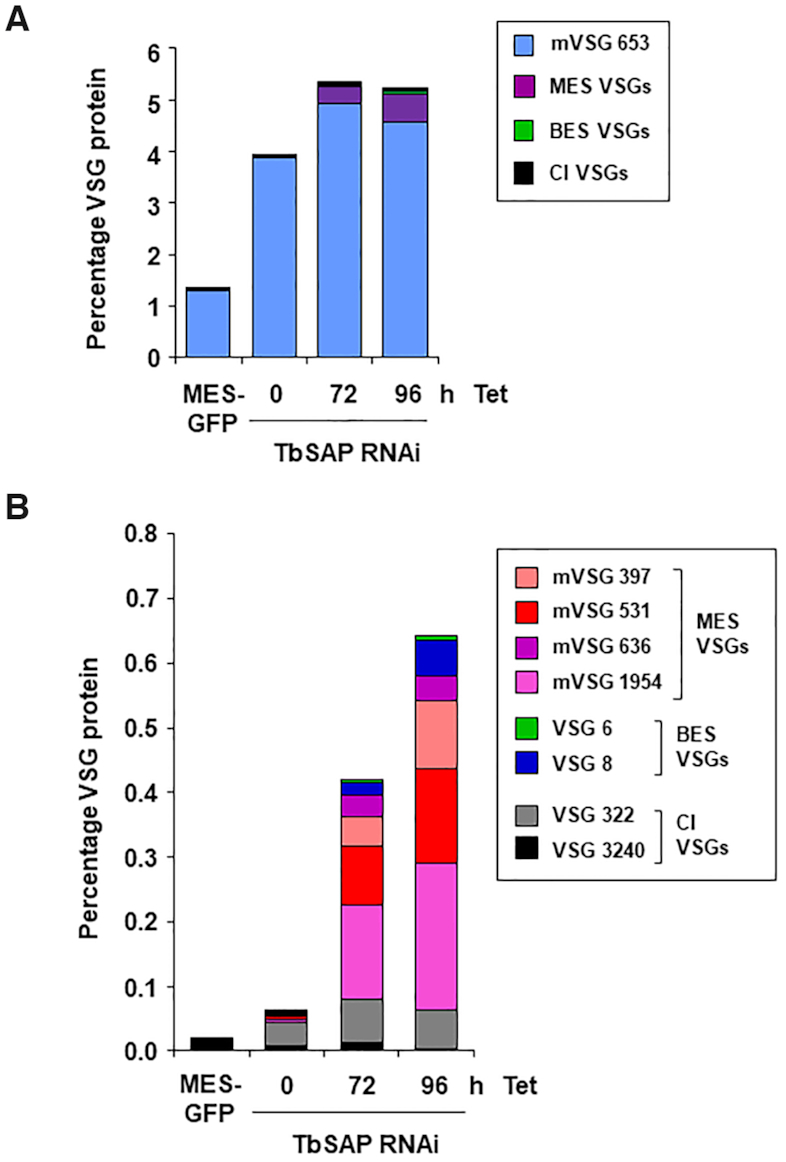
Multiple up-regulated VSGs are present on the cell surface following the induction of TbSAP RNAi (A) Quantitative proteomic analysis using mass spectrometry of surface VSGs cleaved by release of endogenous GPI-PLC after hypotonic lysis. Samples are from the parental VSG221 expressing SM221pur MES-GFP cells (MES-GFP) or cells where TbSAP RNAi has been induced with tetracycline (Tet) for the time indicated in hours (h). VSG221 expressed from the active BES1 is omitted from the BES VSGs dataset, as it displayed an abundance of 95–99% in each sample. In these cell lines MES VSG653 is expressed from readthrough transcription from an ectopic rDNA promoter introduced upstream of the VSG653 gene. The different classes of VSGs are indicated with coloured bars, with MES VSG653 indicated with a blue bar, other MES VSGs (purple), BES VSGs (green bar) or VSGs in chromosome internal (CI) silent VSG arrays (black). Data are the mean of three biological replicates. (B) As in panel (A) only both MES VSG653 and VSG221 are omitted from the VSG dataset, as together they made up >99% of the sample. Different types of VSGs (present in either MESs or BESs) are indicated with coloured bars, with VSGs not located in ESs indicated as CI VSGs (grey and black bars). Data are the mean of three biological replicates.